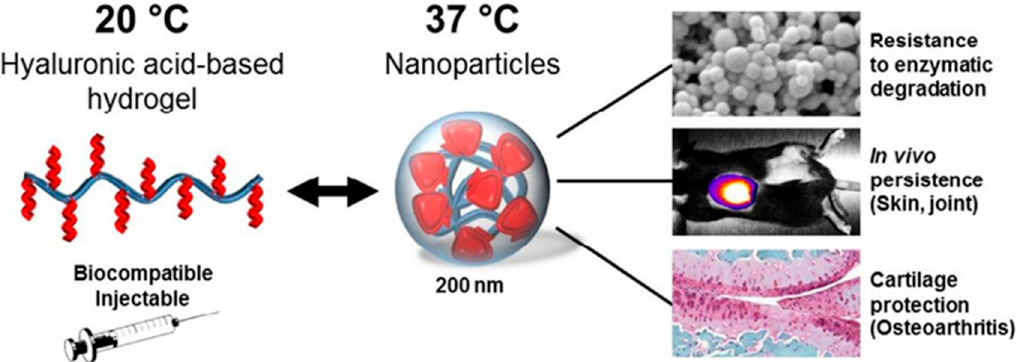
Figure 1. To overcome the inconvenience of repeated injections and the rapid degradation of exoge- nous HA, HA is conjugated to a thermosensitive polymer, enabling the spontaneous formation of nanoparticles (HA Nano) at body temperature, Reprinted from Ref. [30].